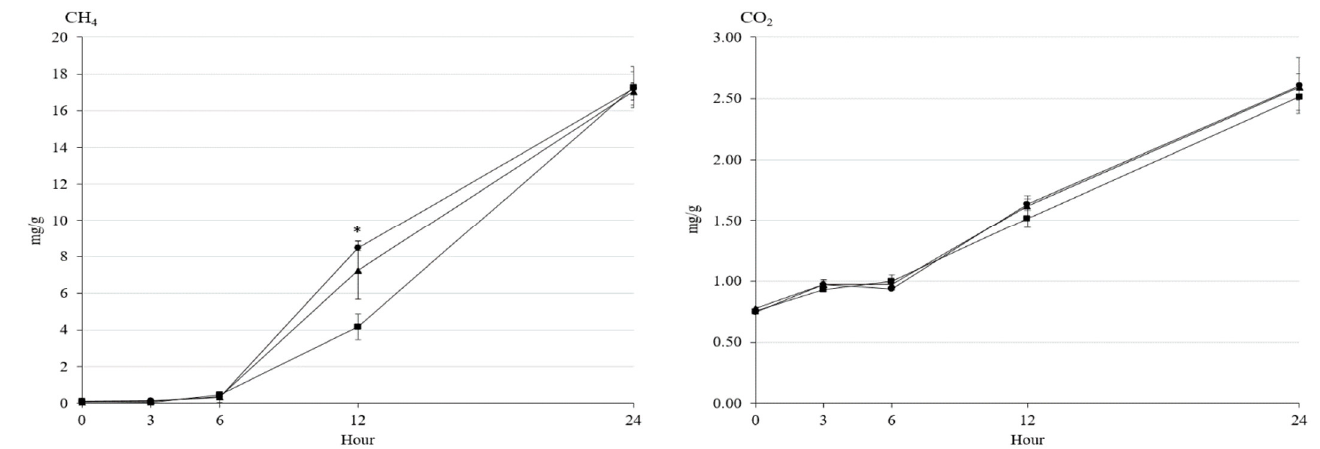
Figure 2. Changes in concentrations of CH 4 and CO 2 during rumen incubation with oil sources con- taining essential fatty acid for 24 h of incubation. Diet with corn oil, C18:2n-6 (●); diet with linseed oil, C18:3n-3 ( ■ ); and diet with Ca-salt, protected C18:2n-6 ( ▲ ). The respective significance levels of dietary treatment, incubation time, dietary treatment × incubation time, and SEM for CH 4 and CO 2 are p < 0.001, p = 0.272, p = 0.052, and SEM = 1.120; and p < 0.001, p = 0.616, p = 0.930, and SEM = 128.76. Different symbols at the same time differ (*, p < 0.05).